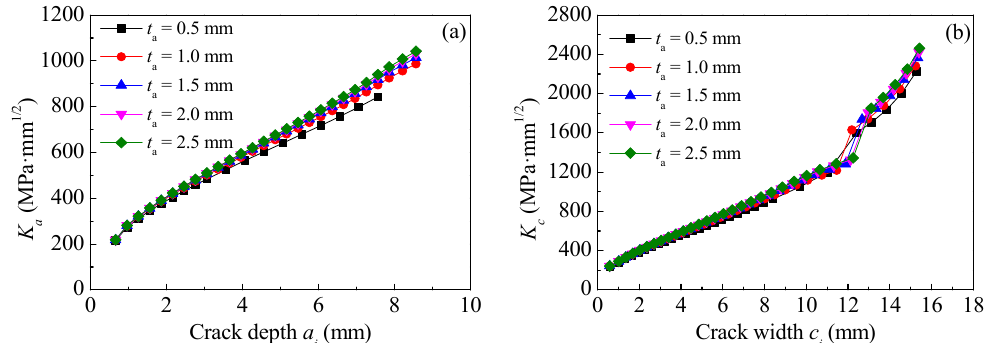
Figure 21. Effect of adhesive thickness on the K ‐ values at crack tip of the corroded steel plate strengthened with CFRP plates: ( a ) K a vs. crack depth a i , and ( b ) K c vs. crack width c i .